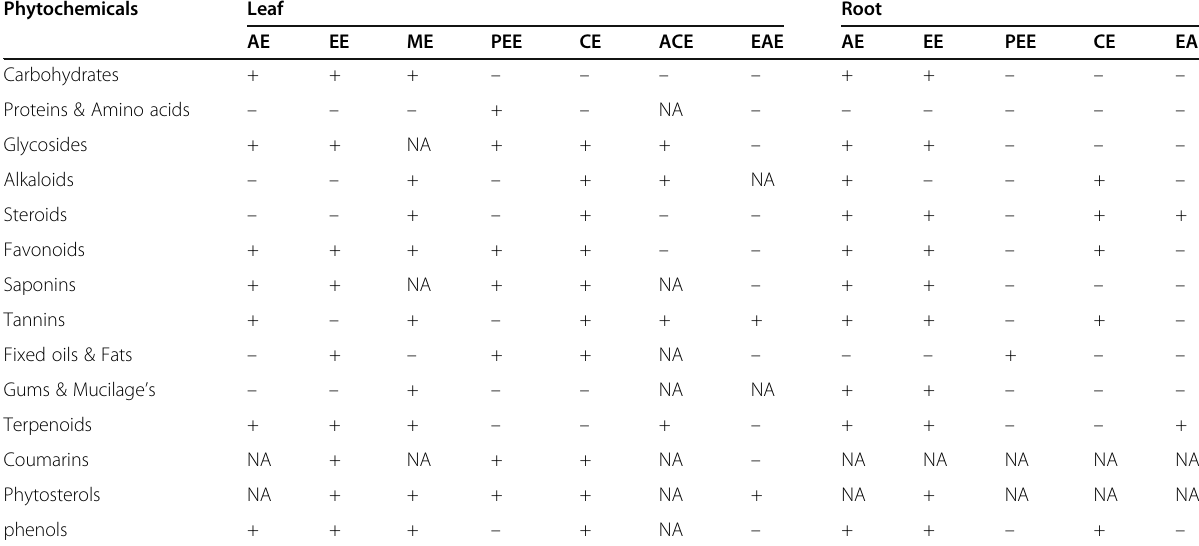
Table 1 Preliminary qualitative phytochemical screening of different solvent extracts on P. daemia leaf and root Phytochemicals Leaf Carbohydrates Proteins & Amino acids Glycosides Alkaloids Steroids